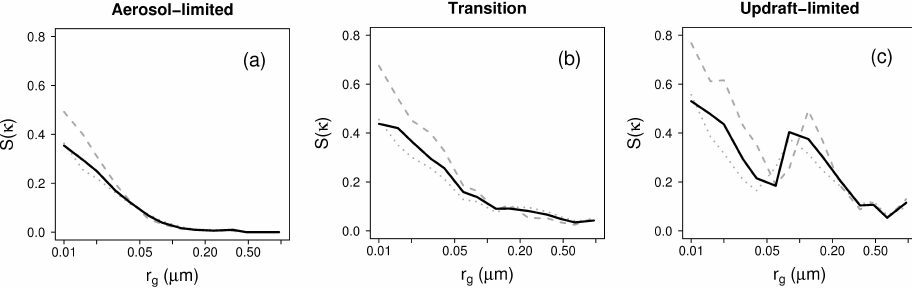
Fig. 2. S ( κ ) computed from parcel model output for κ =0.2 to 0.5 as a function of the choice of initial r g . The sensitivities were averaged over all initial values of T . Each panel displays output from simulations initialized with a single value of w / N cn set to (a) 1e-02, (b) 1e-03, and (c) 1e-04ms − 1 /cm − 3 . Results from simulations at all three values of σ g are plotted as a dashed grey line ( σ g =1.5), a solid black line ( σ g =1.8), and a dotted grey line ( σ g =2.1).